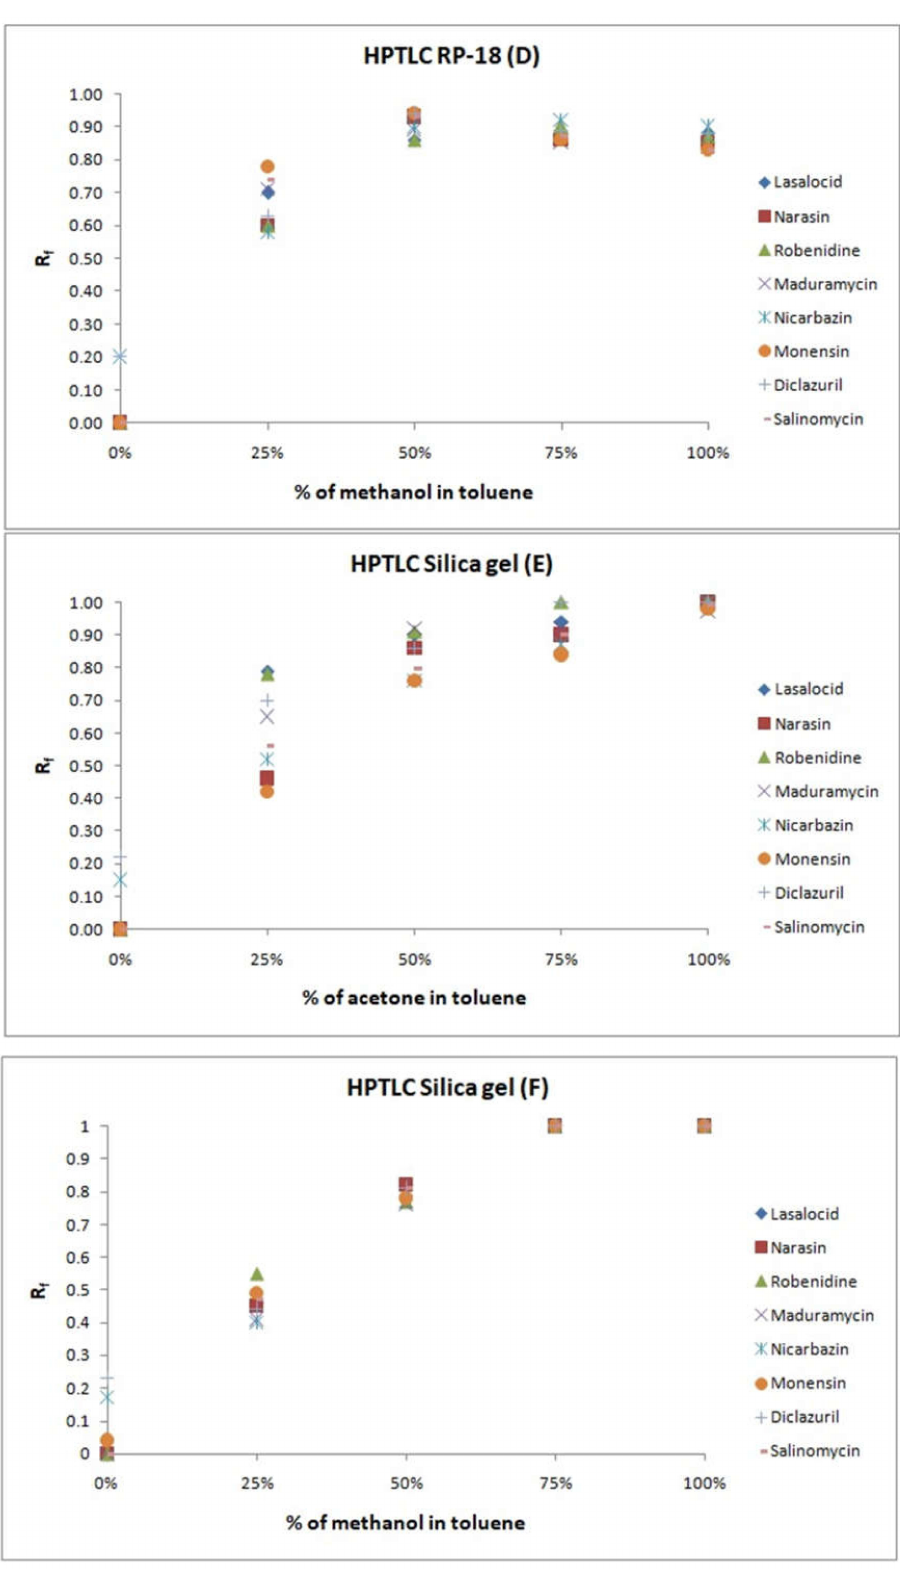
Figure 1. Plots of relationships of substance retention vs. composition of the mobile phase ( A – F ). Stationary phases are described in the headers of the plots, and mobile phases under the